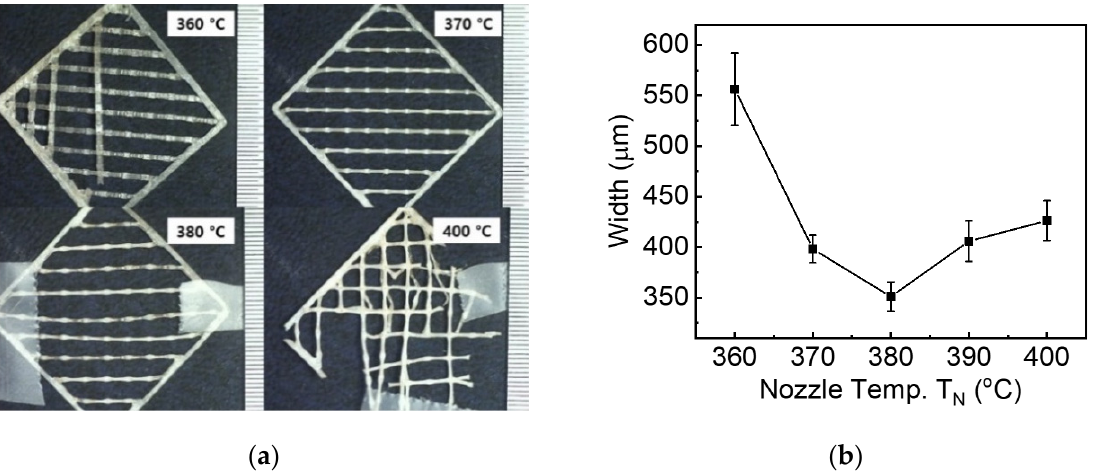
Figure 2. Width of PEEK lines printed at the different nozzle temperatures (T N ). ( a ) Optical images showing the width of the printed lines contacted in consequential layers; ( b ) Line width as a function of nozzle temperature printed at the fixed chamber temperature of 100 °C.